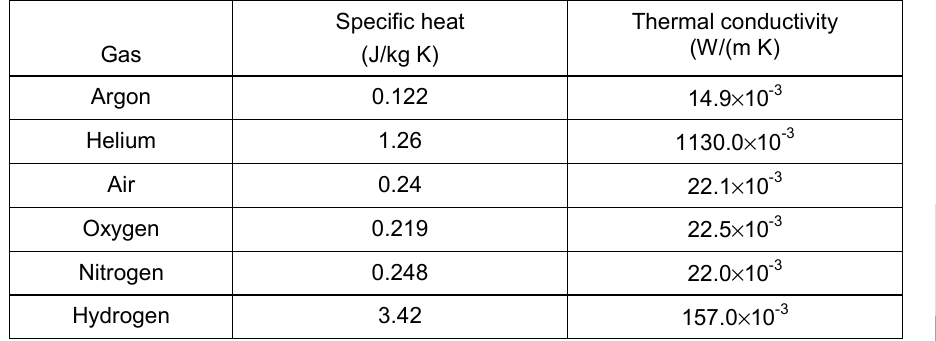
Table 1 – Values of the specific heat and the thermal conductivity of individual